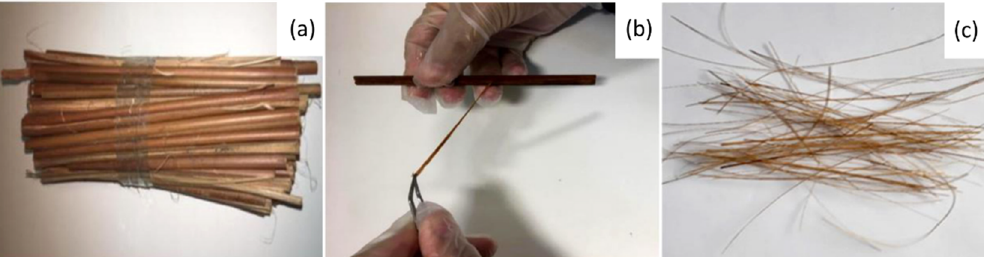
Figure 1. Processing of guaruman fiber: ( a ) stems, ( b ) mechanical separation of fibers, and ( c ) a bundle of guaruman fibers.